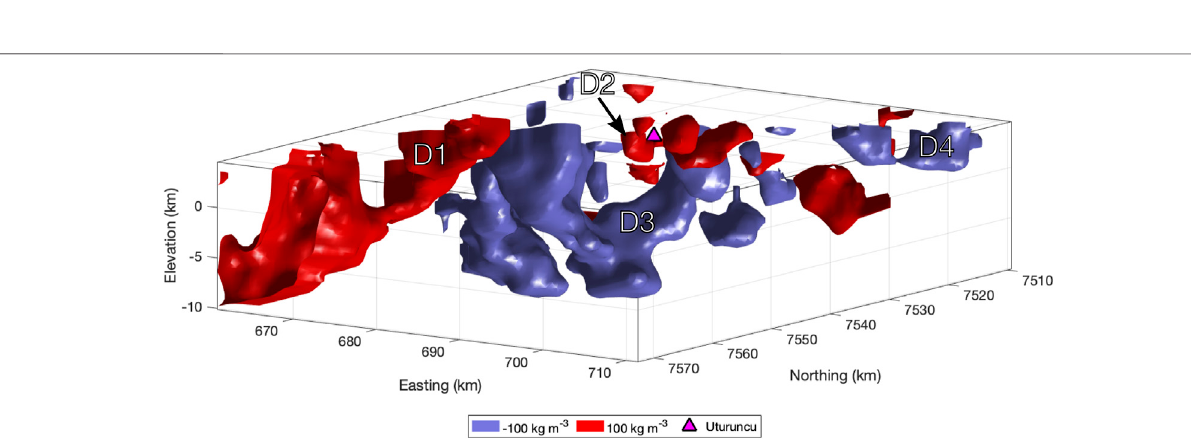
Frontiers in Earth Science |